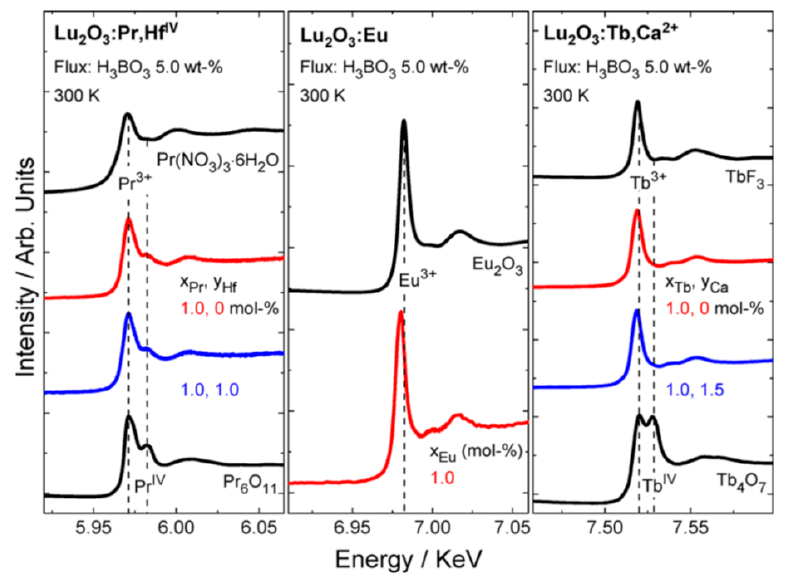
Figure 7. L III edge XANES spectra of Pr ( left ), Eu ( middle ), and Tb ( right ) doped Lu 2 O 3 . Spectra for reference materials are also provided [62]. Copyright © 2016, American Chemical Society.